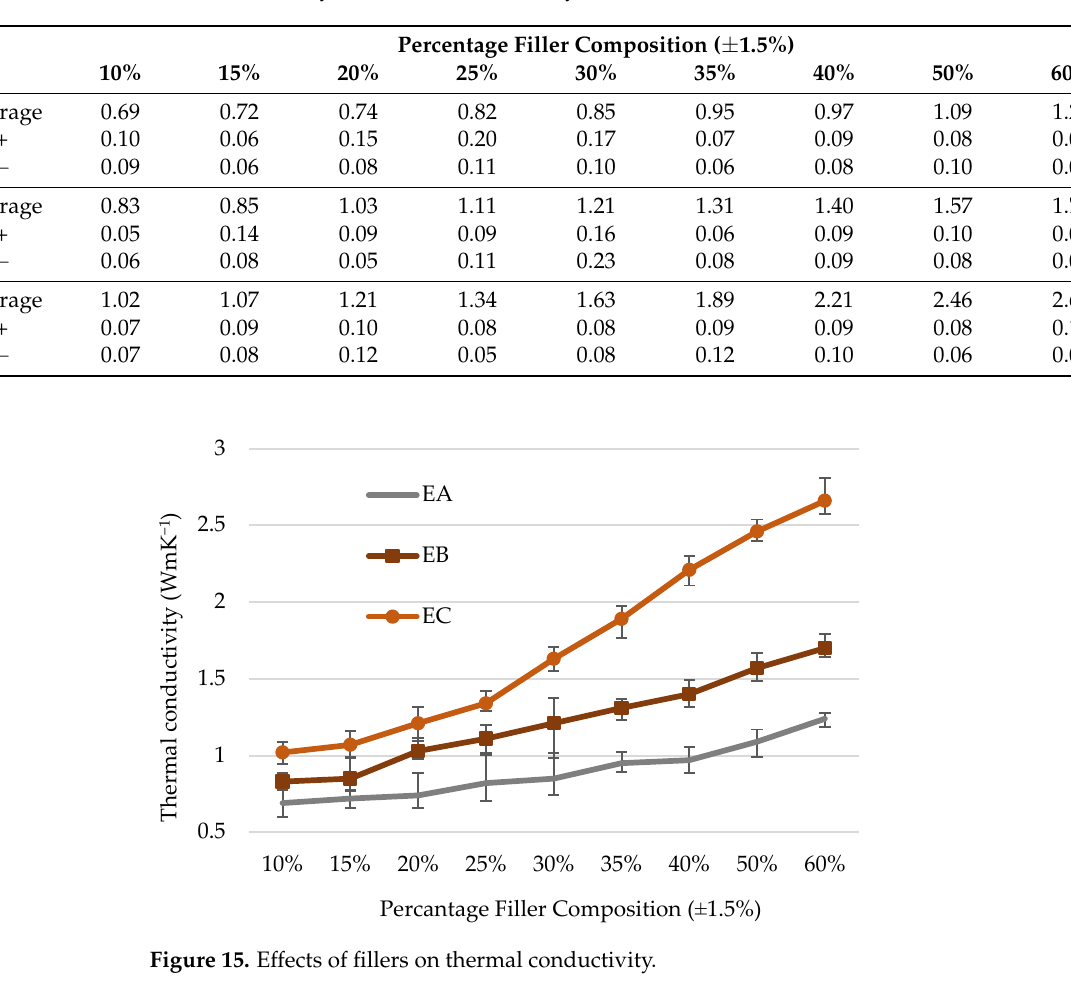
Table 9. Summary of Thermal conductivity values for EA, EB, and EC.